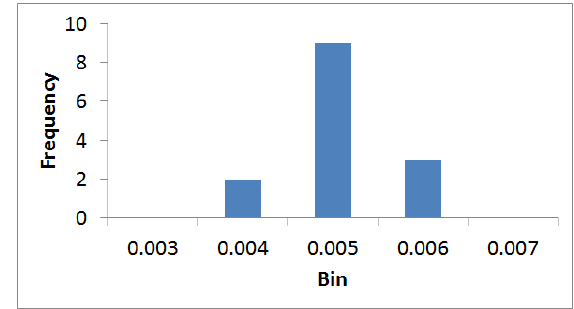
Figure 6. Histogram of one-sigma standard deviation values for 28 randomly selected least-squares plane fittings on vertical wall surfaces within the ILRIS-LR point cloud.